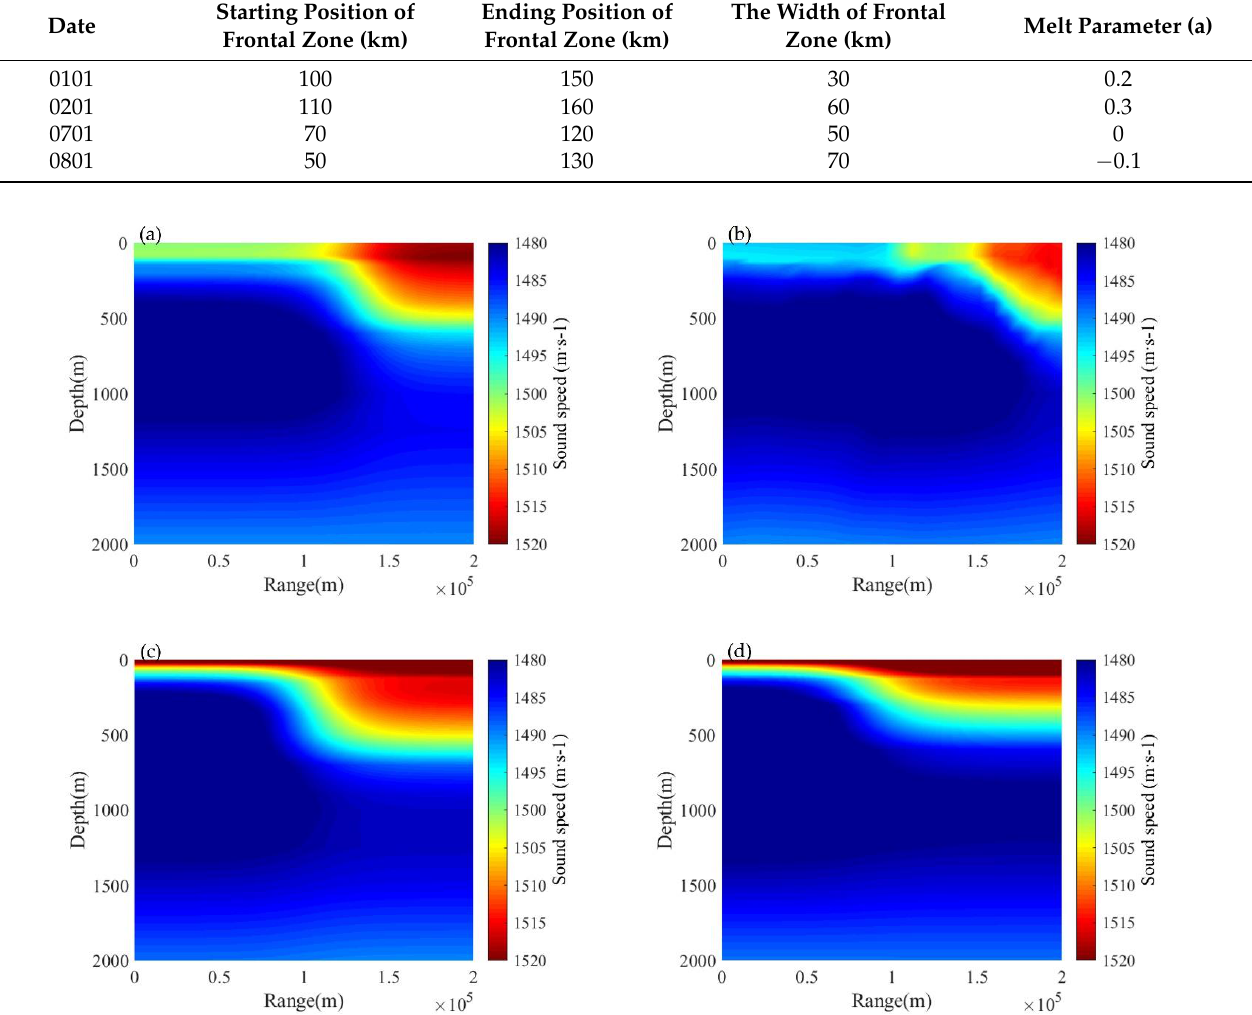
Table 1. Detection results of the frontal zone via FCM and selection of melt parameters at different times at 144 ◦ E section.